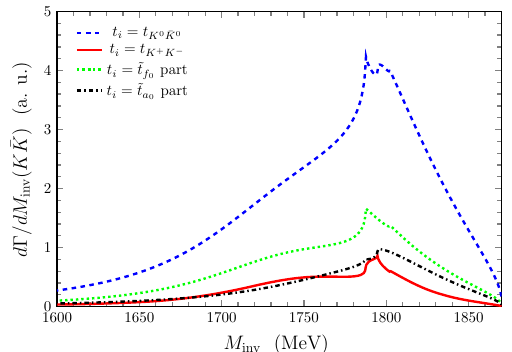
Fig. 8 Mass distributions d (cid:7)/ dM inv for the cases of Eq. (39)